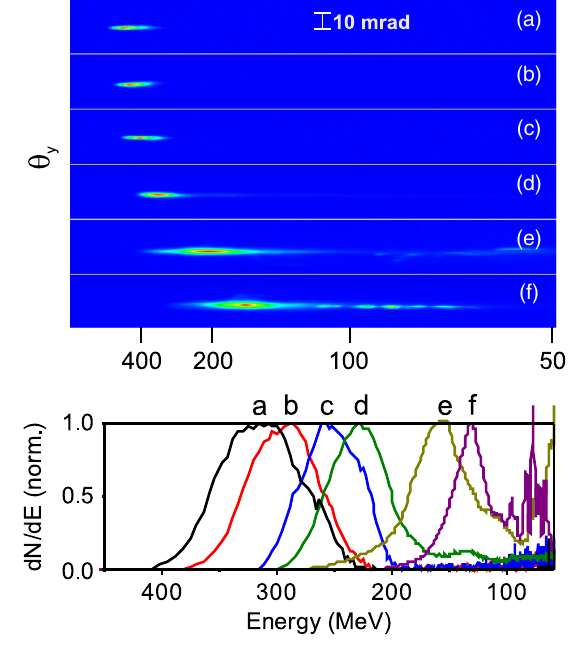
FIG. 4. QME electron spectra as a function of plasma density for the laser power of 43 TW. The values of the plasma density are (a) 6, (b) 6.6, (c) 7.2, (d) 7.8, (e) 8.4, and (f) 9 : 6 (cid:2) 10 18 cm (cid:3) 3 . The corresponding charge on the LANEX screen is (a) 3, (b) 3, (c) 7, (d) 15, (e) 32, and (f) 45 pC. The angular divergence of the beam measured along the nondispersed axis is (cid:1) 3 mrad for the panels (a)–(d) and (cid:1) 4 mrad for (e)–(f). The color scale is normalized for each